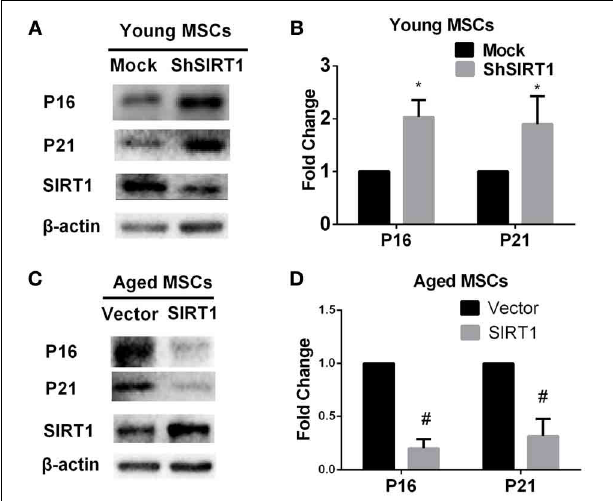
FIGURE 3 | SIRT1 positively regulates P16 and P21 expression in MSCs. SIRT1 knockdown in young MSCs was associated with increases in P16 and P21 expression, with representative protein bands shown in (A) and quantified in a bar graph shown in (B) . In contrast, SIRT1 overexpression in aged MSCs decreases P16 and P21 expressions. Representative western blot images (C) and the quantitative analysis results (D) were shown. Data are expressed as mean ± SD (three independent experiments, n = 5 rats/group). ∗ Implies P < 0 . 05, compared to mock-young MSCs. #, P < 0 . 05, compared to vector-aged MSCs.